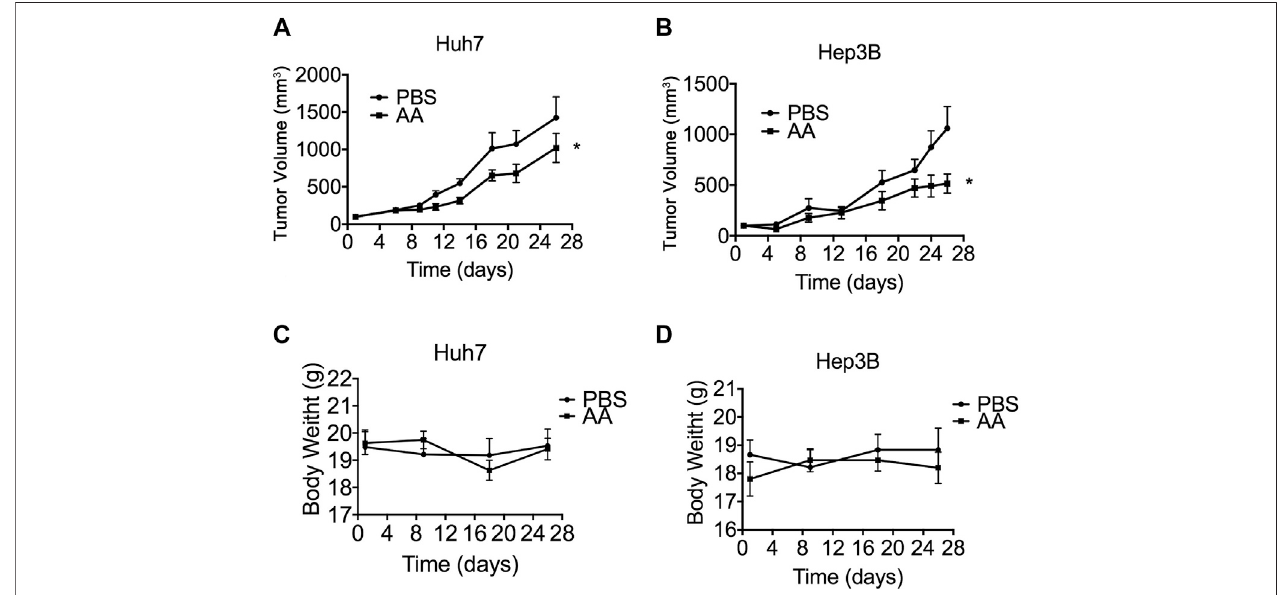
FIGURE3| AAsuppressestumor growth invivo .2 × 10 6 Huh7orHep3Bcellswereinoculatedsubcutaneouslyintonudemice.3 weekslater,PBS(controlgroup) or 4 g/kg AA was injected intraperitoneally twice daily for 26 days. Tumor volume was measured every 2 – 3 days and animal body weight was measured every 9 days. (A) Volumes of tumors formed by Huh7 cells. (B) Volumes of tumors formed by Hep3B cells. (D) Body weight of animals engrafted with Huh7 cells. (D) Body weight of animals engrafted with Hep3B cells * p < 0.05.